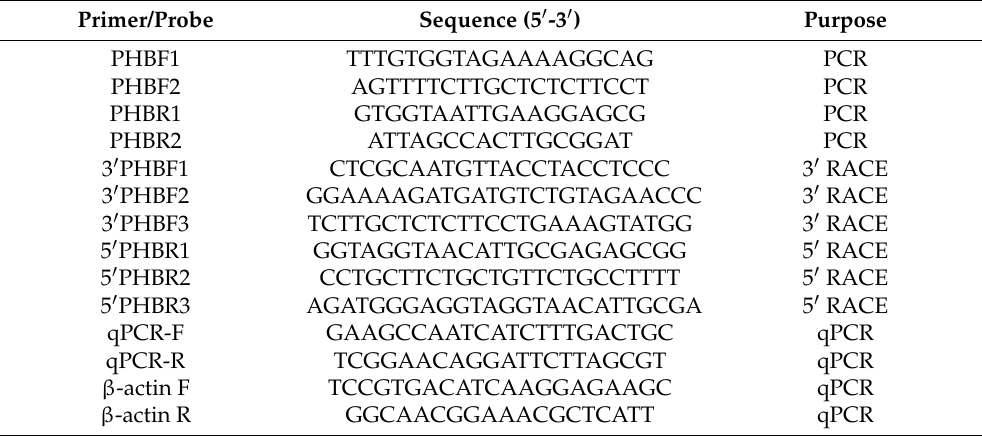
Table 1. The primer and probe used in this study for phb cDNA full-length